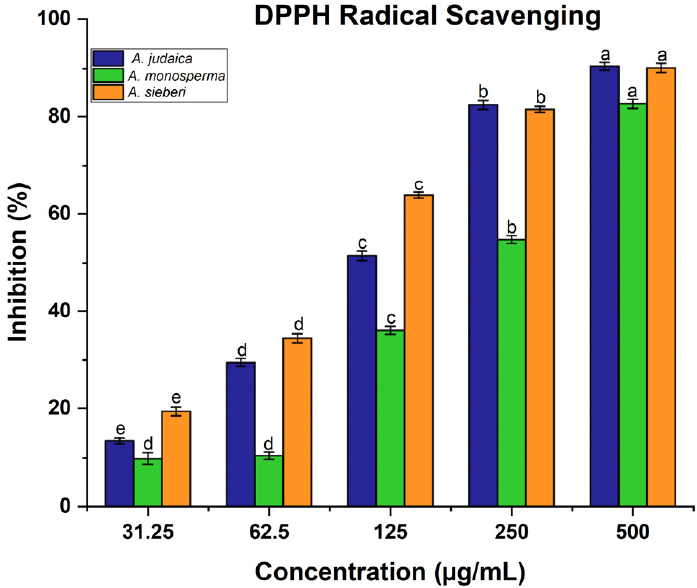
Figure 5. DPPH estimation: the reported data are mean values based on three replicates ± SD. Average in the same column with different letters are significantly different at ( p < 0.05).